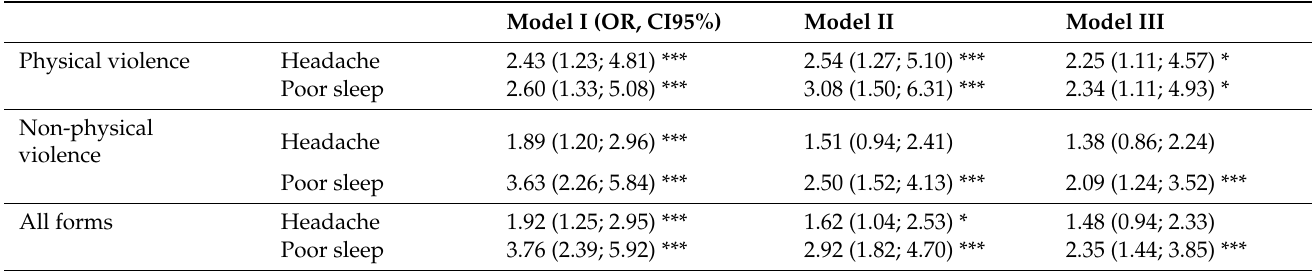
Table 3. Association of workplace violence with headaches and poor sleep. Logistic regression analysis.